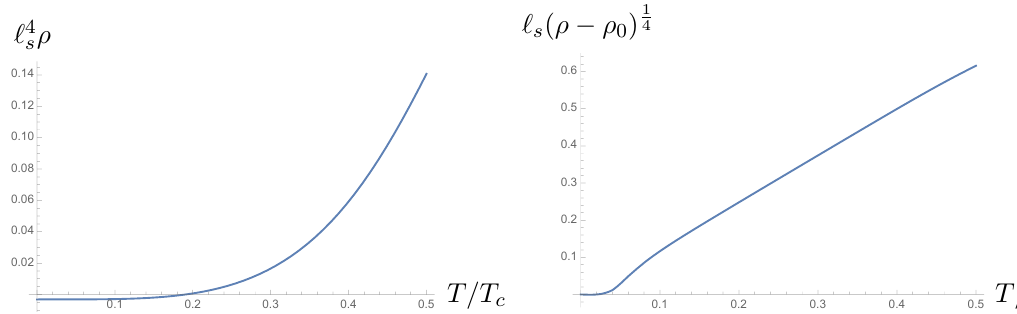
Figure 5 . Left: the 1-loop energy density in the low temperature regime T < T c for n = 4 . Right: the fourth root of ρ − ρ